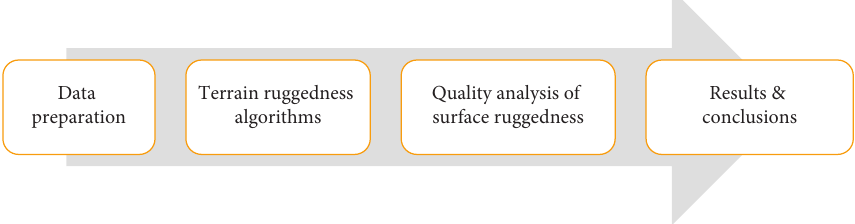
Figure 1: Schematic representation of the research methodology.